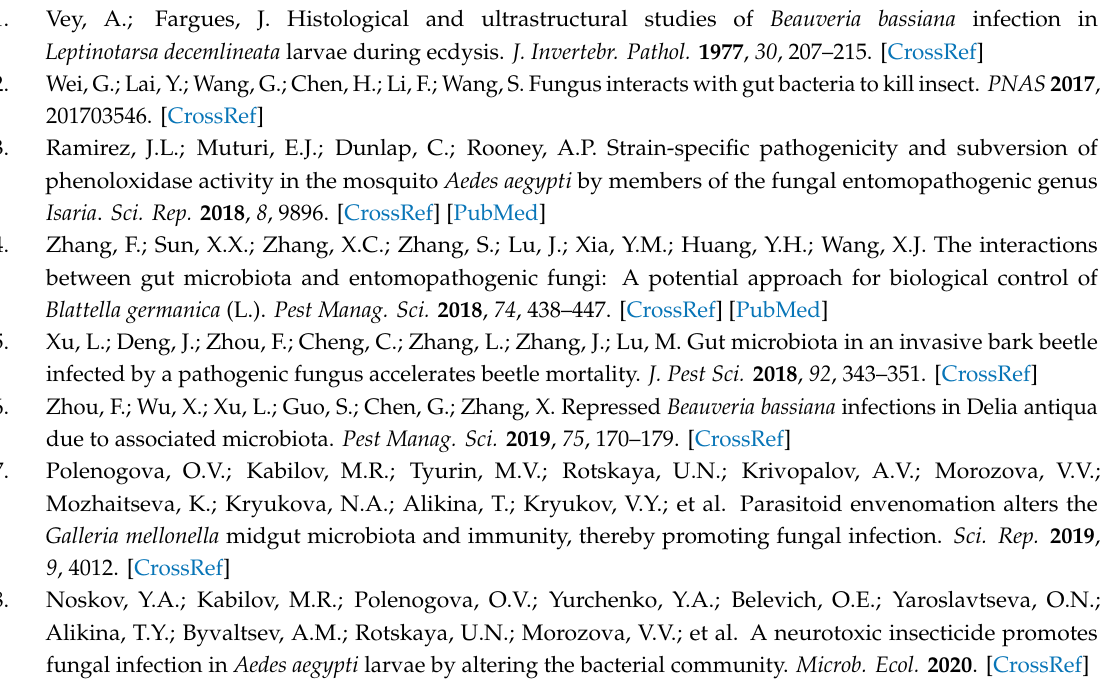
Figure S1. Rarefaction curves of the OTU numbers for each sample. Table S1. List and description of genes and primer sequences used in qPCR. Figure S2. Diversity indexes of bacterial communities in the midgut of wax moth larvae at 96 h post injection of C. militaris (2500 conidia per larva) with incubation at 15 ◦ C and 25 ◦ C. Indexes were calculated for OTU levels. Di ff erent letters indicate significant di ff erences between treatments (Dunn’s test, p < 0.05). Figure S3. Wax moth larvae overgrown with B. bassiana (A) and M. robertsii (B) at four days after injection with 2500 conidia per larva and incubation at 25 ◦